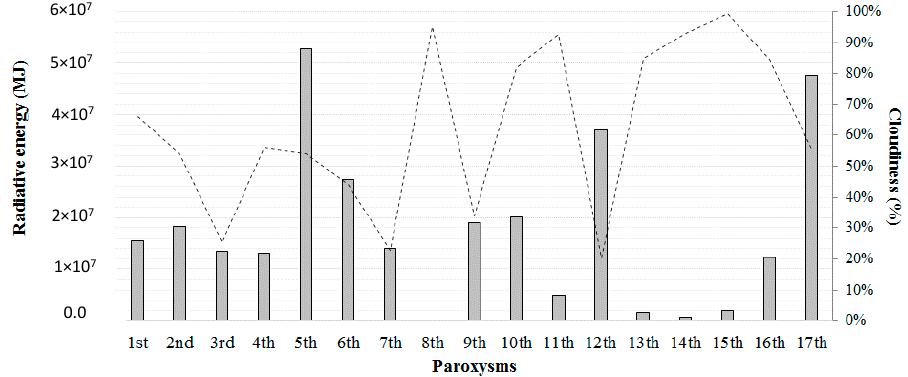
Figure 9. Radiative energy retrieved from infrared SEVIRI data of 16 February–1 April 2021 with the indication of paroxysms and cloudiness (dotted line).